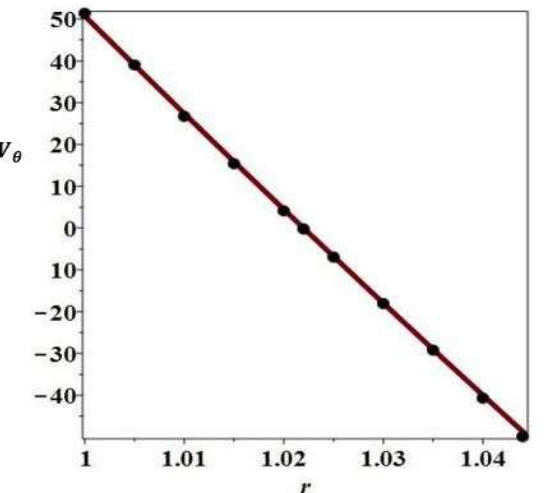
Figure 3. 𝑉 (cid:3087) (r , 𝜃 = 𝜋/2) versus r for Ra = 100 and R = 2 1/16 obtained analytically (continuous line) and using numerical direct simulations (black dots).